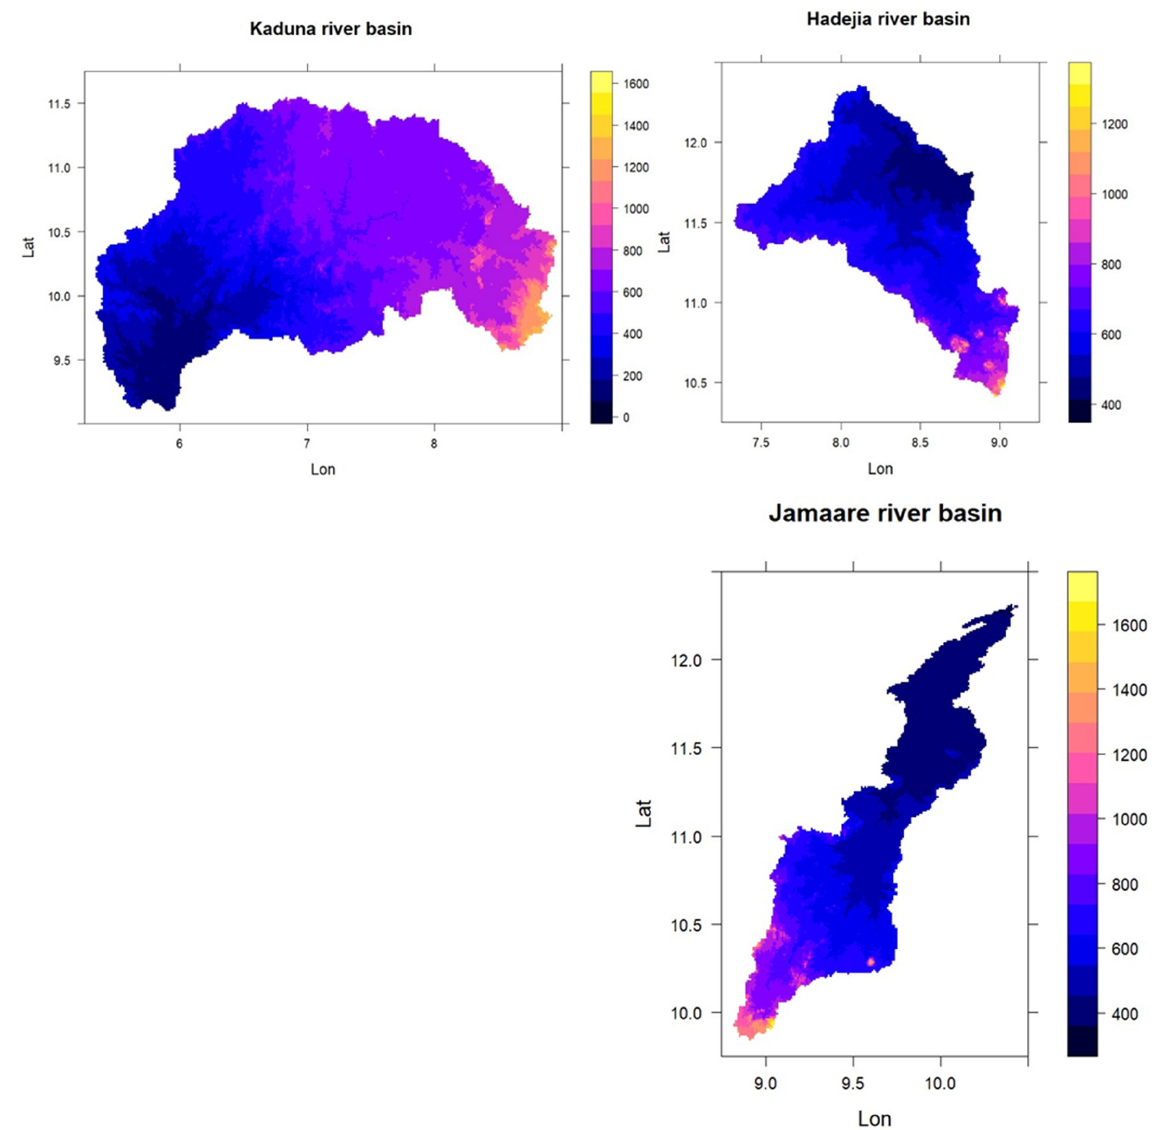
Figure 2. DEM for Kaduna (Basin No. 572), Hadejia (GRDC No. 1837410), and Jamaare river basins (GRDC No. 1837250) [66].